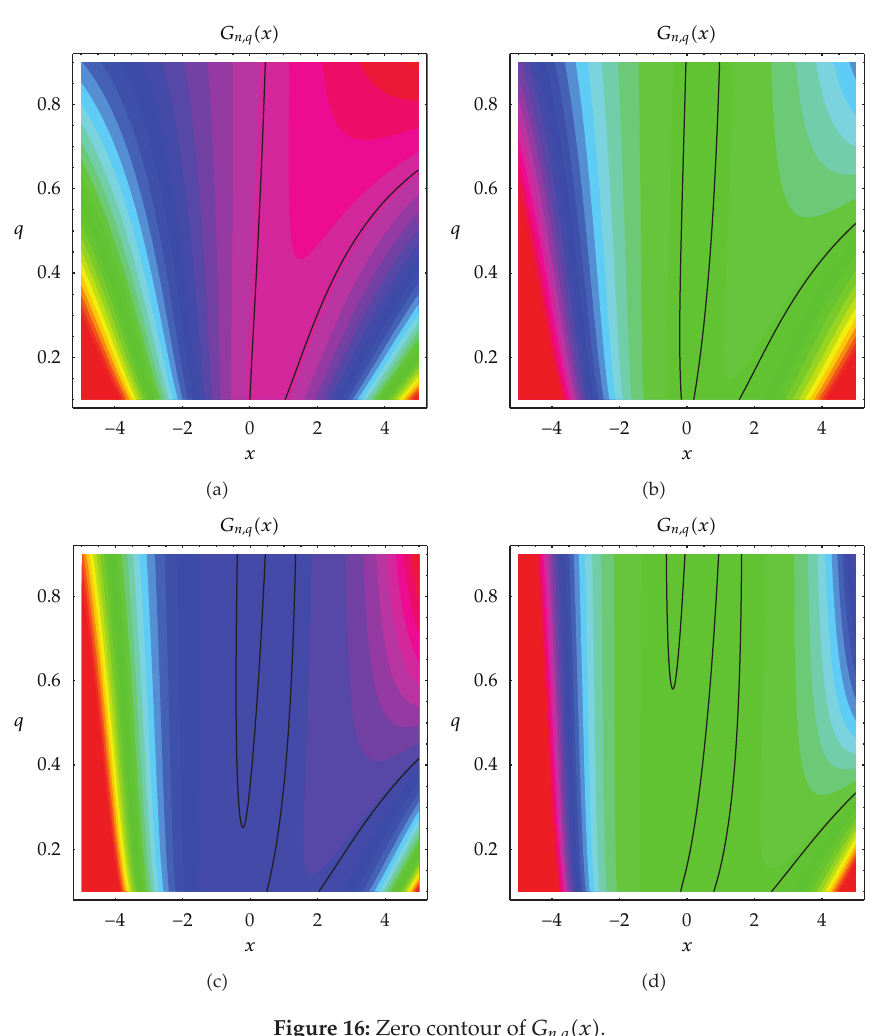
Figure 16: Zero contour of G n,q (cid:2) x (cid:3)